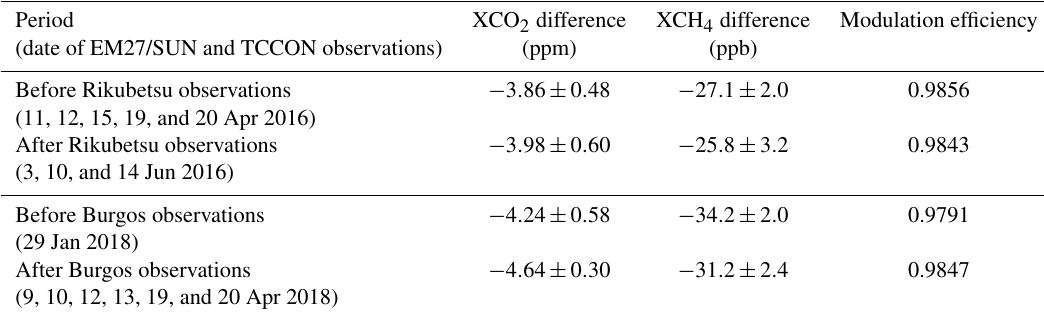
Table 3. The differences in XCO 2 and XCH 4 between the EM27/SUN and Tsukuba TCCON data (EM27/SUN minus TCCON) before and after the transports of the EM27/SUN instrument. Note that correction factors are applied to only TCCON data. Also shown is the modulation efficiency of the EM27/SUN